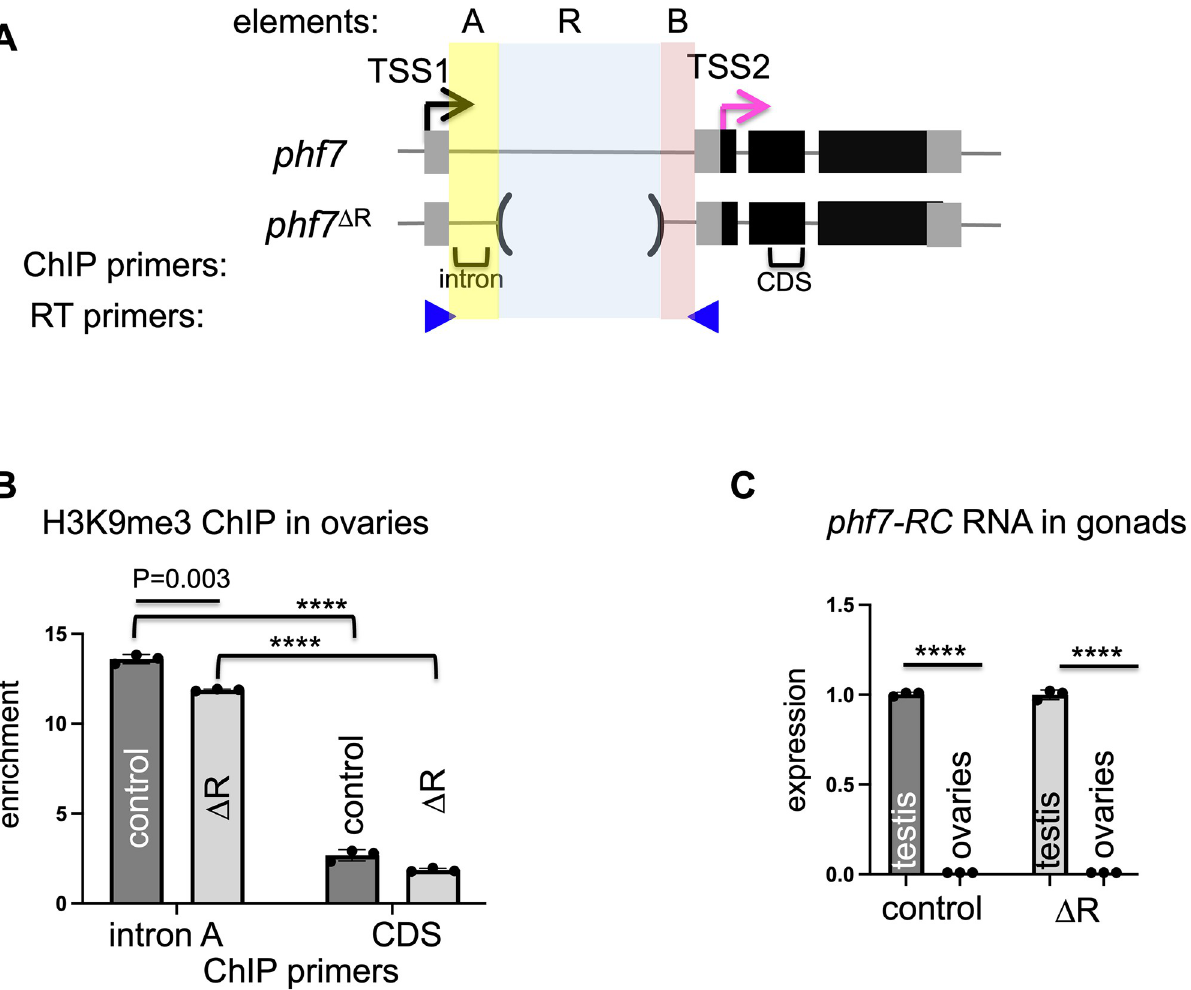
Fig 1. H3K9me3 deposition and sex specific transcriptional regulation are maintained in phf7 Δ R ovaries. ( A) Diagram of the phf7 + and phf7 Δ R alleles. Exons are represented by boxes, flanking DNA, and introns by lines, black boxes are coding sequences, and grey boxes are untranslated regions (UTRs). The sequence elements A, R, and B location within the first intron are shaded in yellow, blue, and pink. In ovaries, transcription initiates from TSS2 (pink arrow), whereas an H3K9me3-mediated mechanism represses transcription from TSS1 (black arrow). Locations of primers for ChiP-qPCR and RT-qPCR are indicated by brackets & blue arrowheads. (B) H3K9me3 accumulation at the endogenous phf7 locus in control ( y 1 w 1 ) and mutant ovaries. ChIP-qPCR measured H3K9me3 signal at the phf7 locus. ChIP to input enrichment is normalized to rp49 . (C) Expression of the testis specific